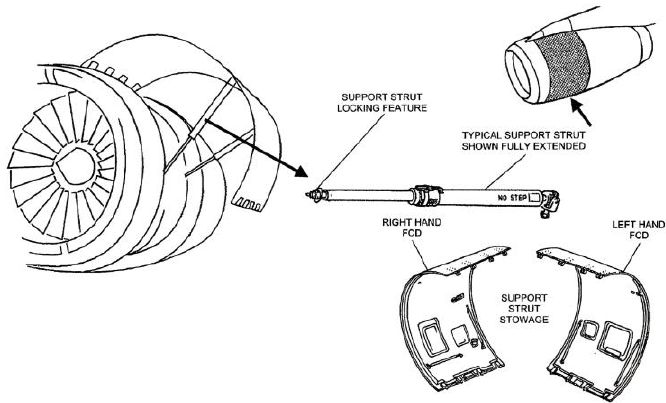
Figure 5. A320 fan cowl doors and support struts.